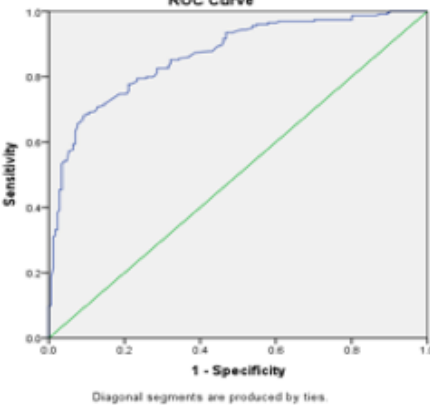
Fig. 6: ROC curve for left hand index of male.